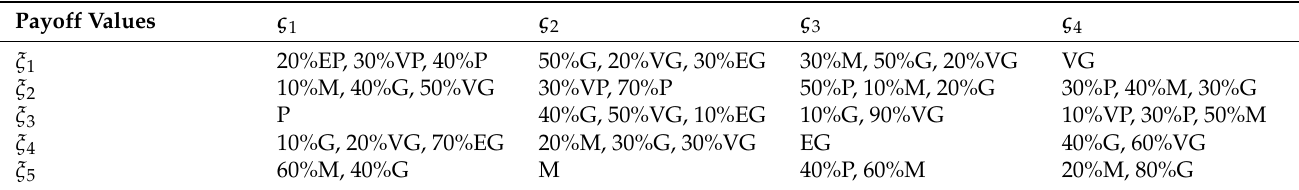
Table 1. Payoff matrix values with probabilistic linguistic